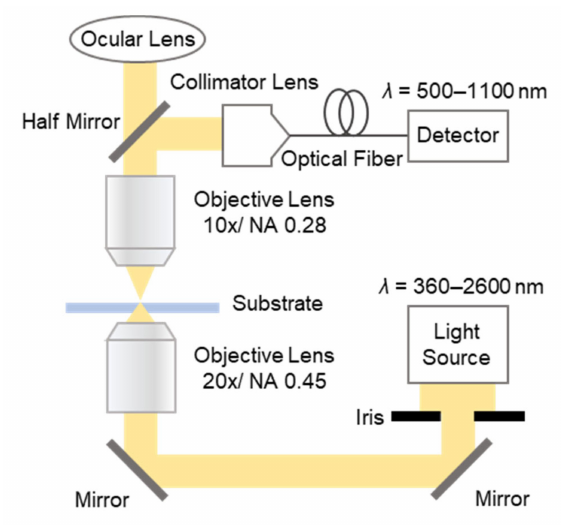
Figure 2. Schematic illustration of the optical micro-spectroscopy system used for the evaluation of the optical characteristics of the fabricated MIM